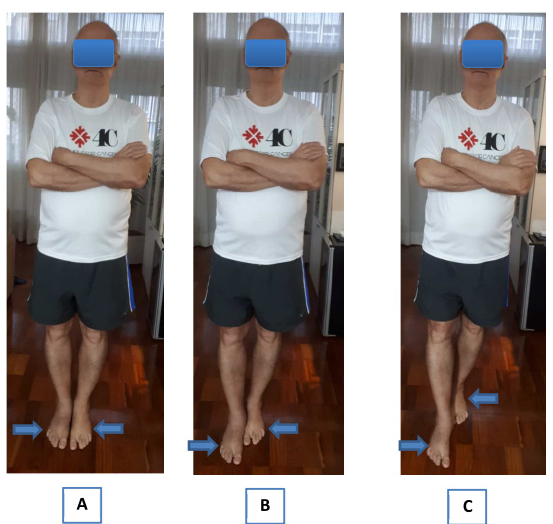
Figure 4. The individual standing feet side-by-side ( A ) or in semi-tandem ( B ) or in tandem position ( C ). The arrows indicate the position of a foot in relation to the other foot in ( A ), ( B ), and ( C ).